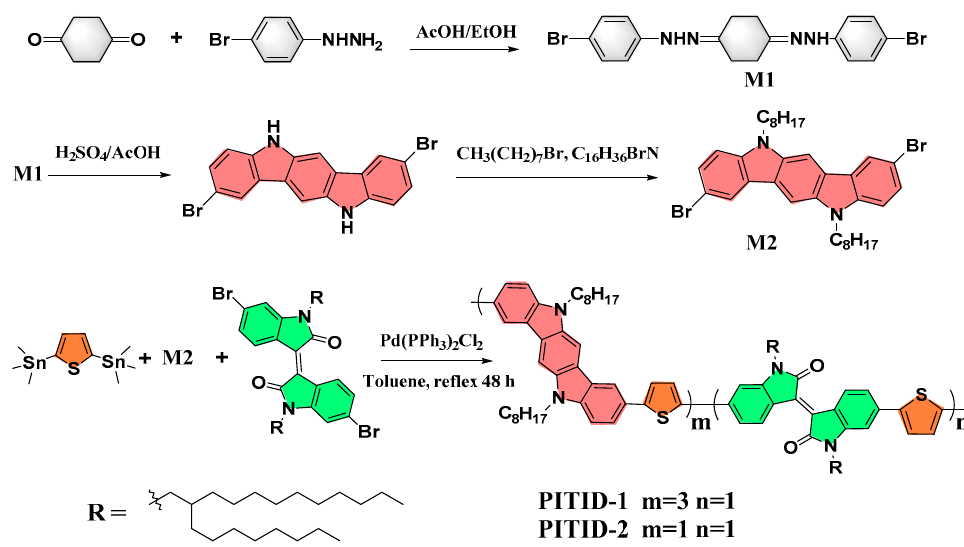
Scheme 1. The synthetic route of the conjugated polymers PITID-1 and Scheme 1 . The synthetic route of the conjugated polymers PITID-1 and PITID-2.